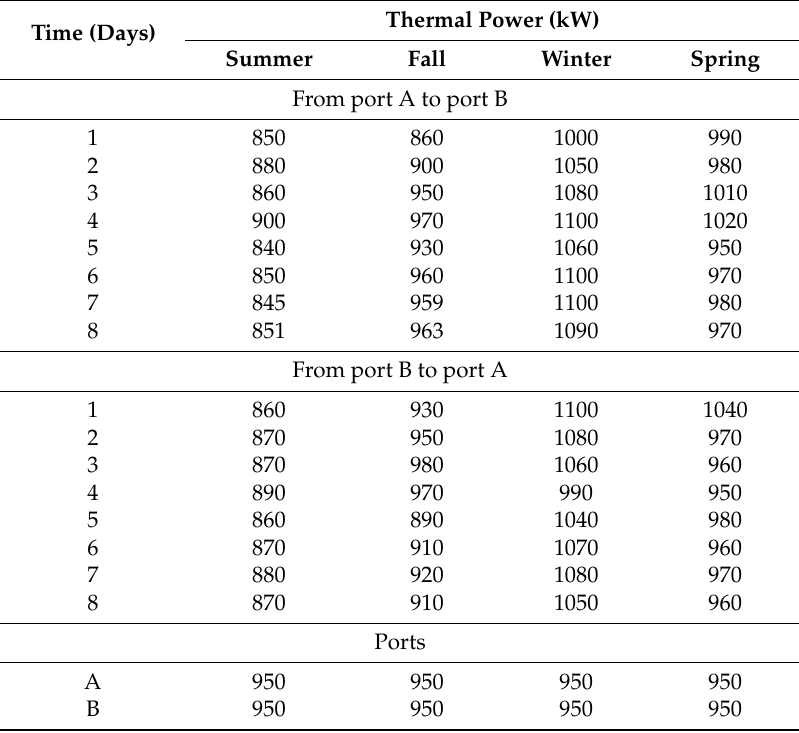
Table 21. Thermal power demands for each